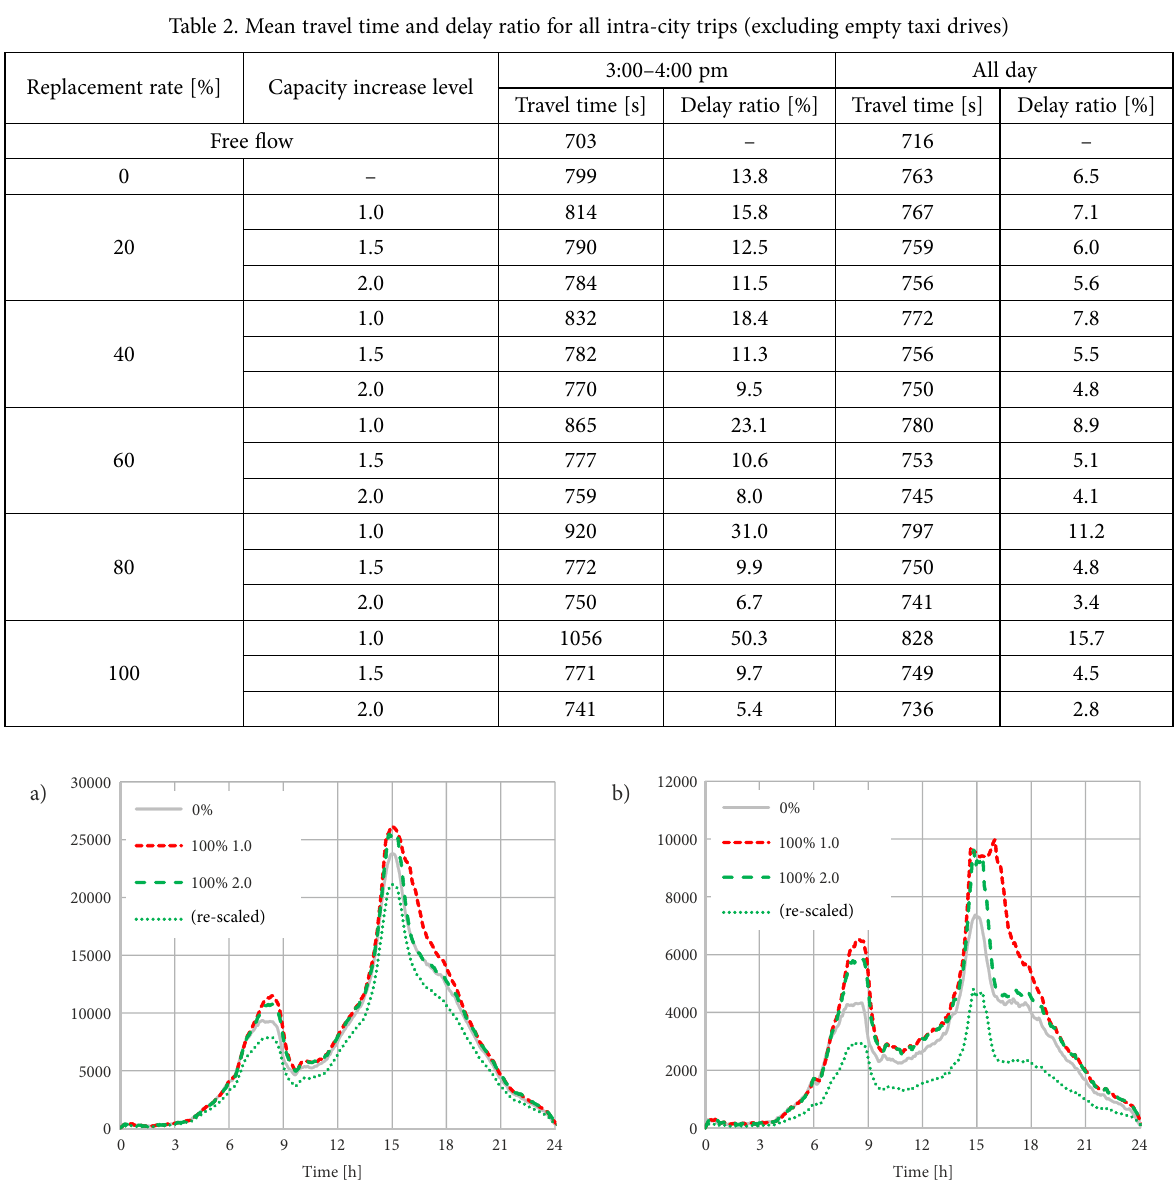
Figure 4. Number of vehicles driving in the network: a – all trips; b – intra-city trips (the dotted green curve is a re-scaled 100%, 2.0 series, where each AV is counted as 0.5 CDVs to adjust for their reduced flow capacity significantly lowers congestion. The dotted green